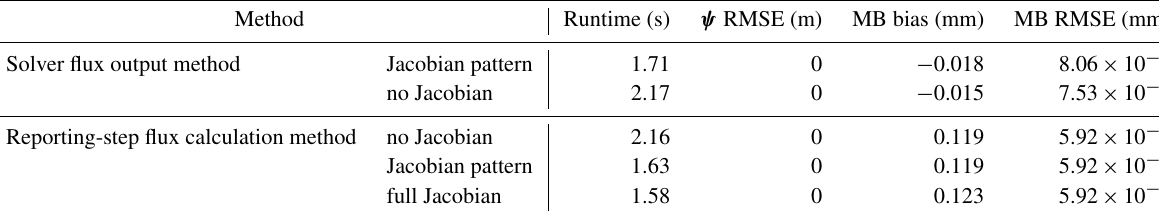
Table A4. Model performance using different approaches to define the Jacobian matrix.